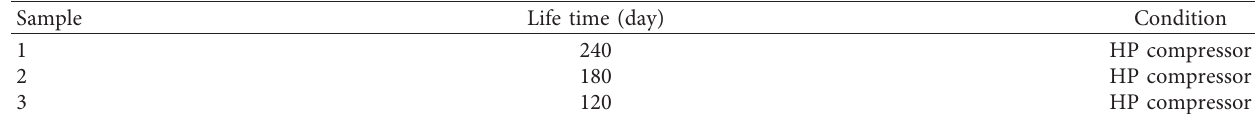
Table 1: Lifetime of specimens.